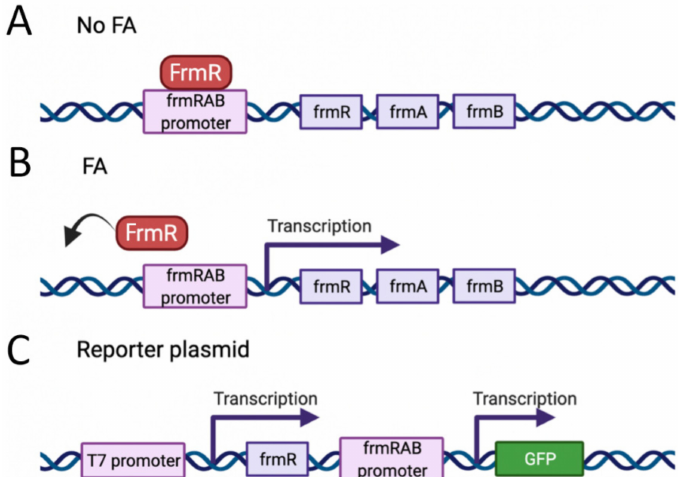
Figure 10. ( A ) FrmR repressor protein binds to the promoter region, preventing transcription of the downstream genes. ( B ) When FA concentration increases, it reacts with the nucleophilic Cys36 of FrmR, inducing its conformational changes; this leads to FrmR dissociation from the promoter,